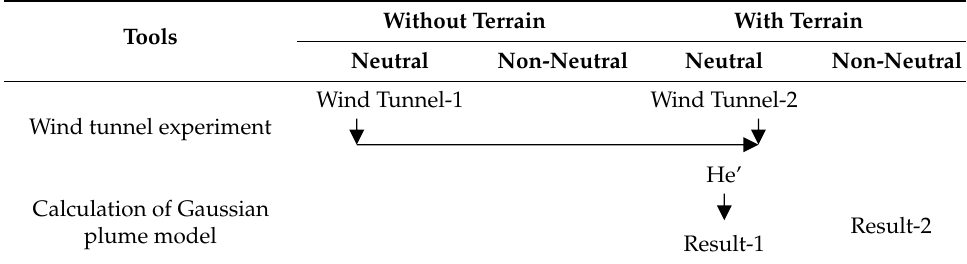
Table 3. Schematic representation of the calculation scheme for nuclear safety assessment. Tools